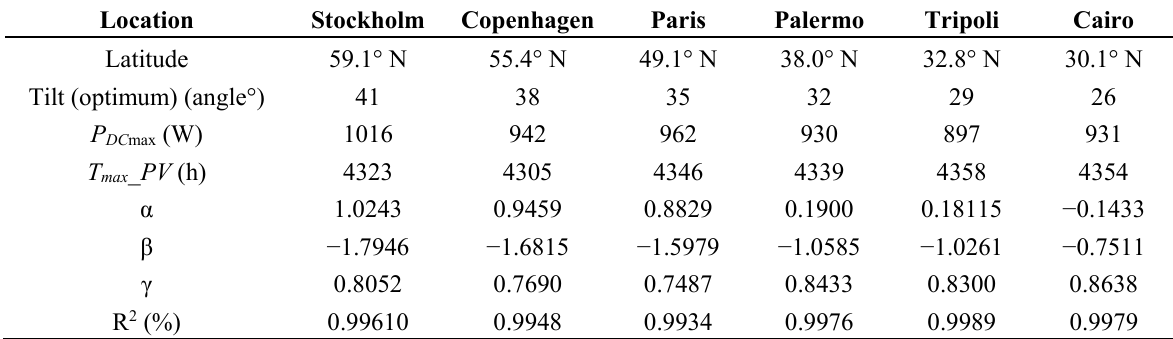
Table 1. Coefficients of 1-kWp PV power plants in some cities by real irradiance simulated with PVsyst software. Dbase Meteonorm